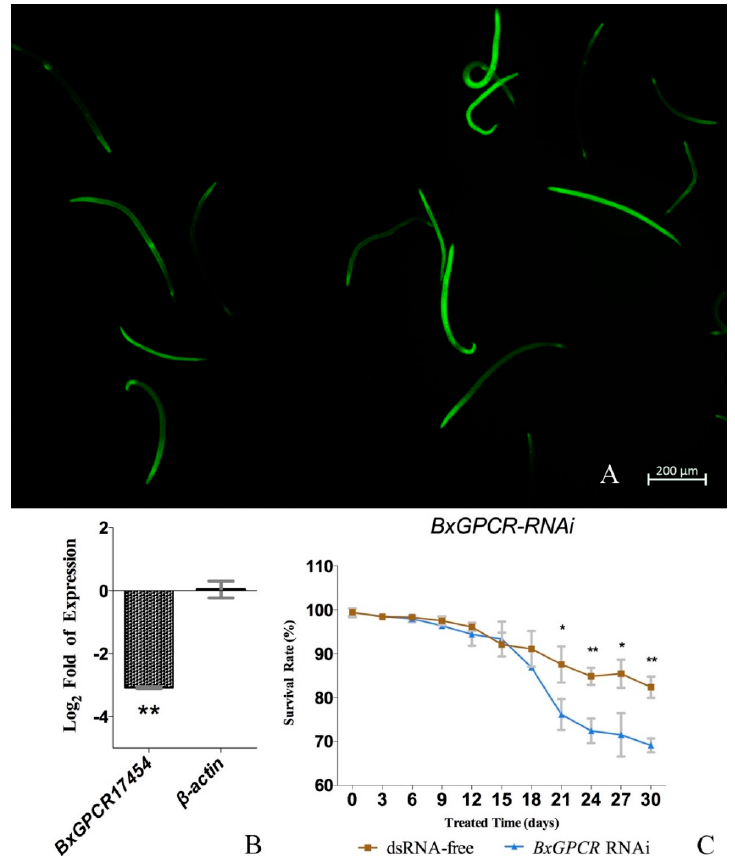
Figure 5. RNAi validaton of BxGPCR17454. ( A ). B. xylophilus soaked in fluorescein isothiocyanate (FITC) revealed green fluorescent signal under ultraviolet light. ( B ). BxGPCR17454 RNAi e ffi ciency